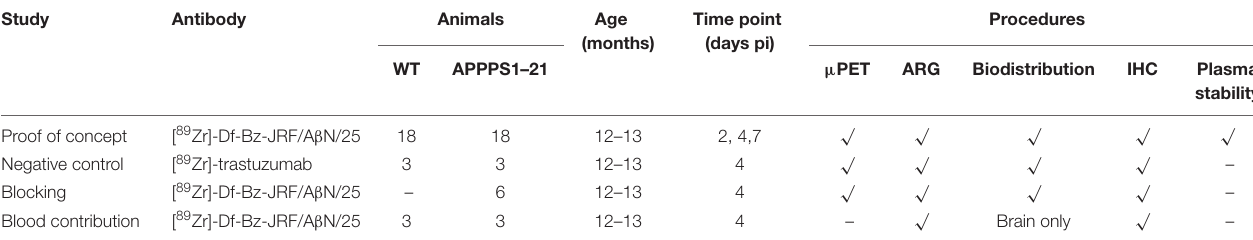
TABLE 1 | Overview of study